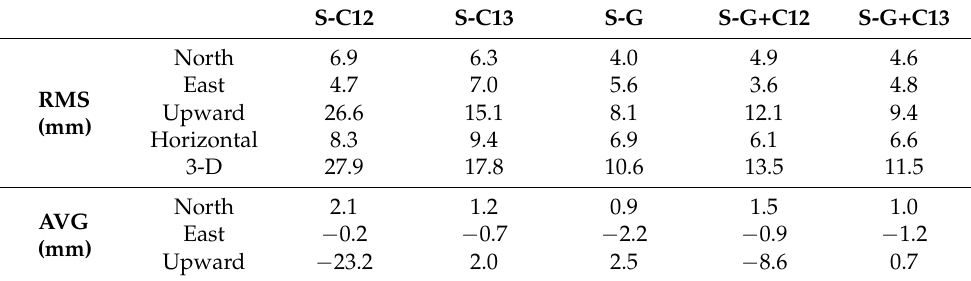
Table 3. Static PPP positioning accuracy and average RMS value